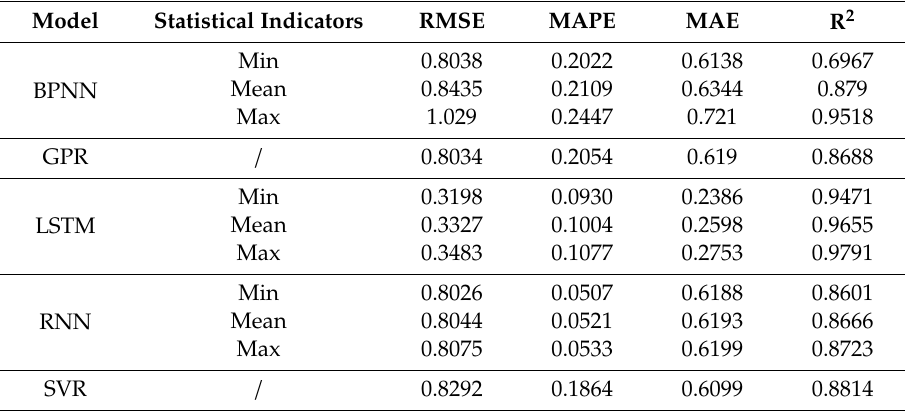
Table 4. Evaluation prediction results in Case